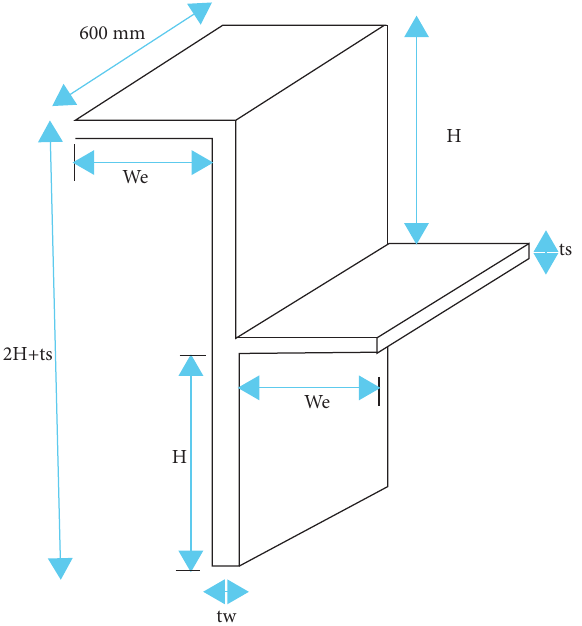
Figure 4: Geometric dimension of model